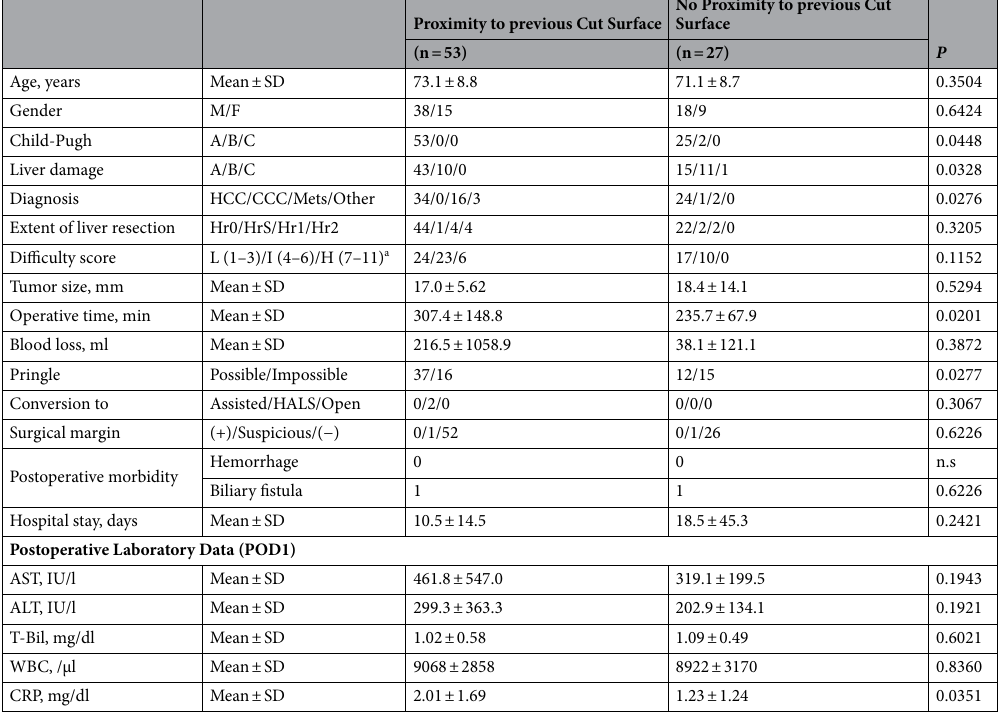
Table 3. Patient characteristics and surgical results of laparoscopic repeat liver resection classified by proximity to previous cut surface of the last hepatectomy. HCC hepatocellular carcinoma, CCC cholangiocellular carcinoma, Mets metastasis, HALS hand-assisted laparoscopic surgery, n.s. not significant. a L: low, I: intermediate, H: